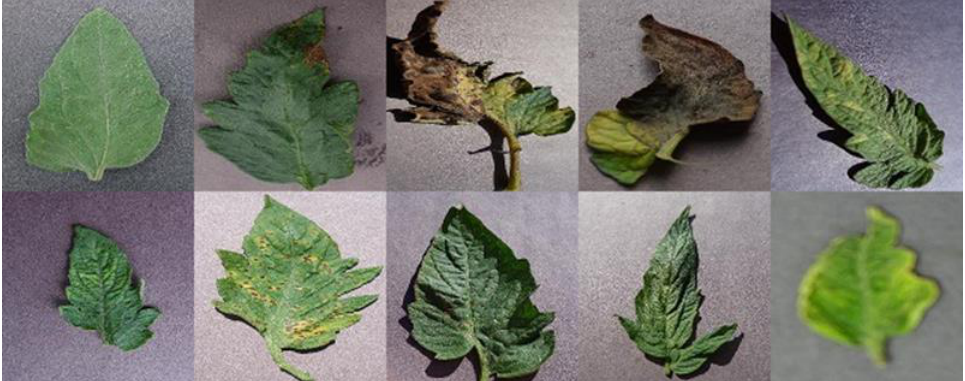
Figure 2. Examples of tomato leaf diseases: healthy, Tomato bacterial spot (TBS), Tomato early blight (TEB), Tomato late blight (TLB), Tomato leaf mold (TLM), Tomato mosaic virus (TMV), Tomato septoria leaf spot (TSLS), Tomato target spot (TTS), Tomato two-spotted spider mite (TTSSM), and Tomato yellow leaf curl virus (TYLCV),